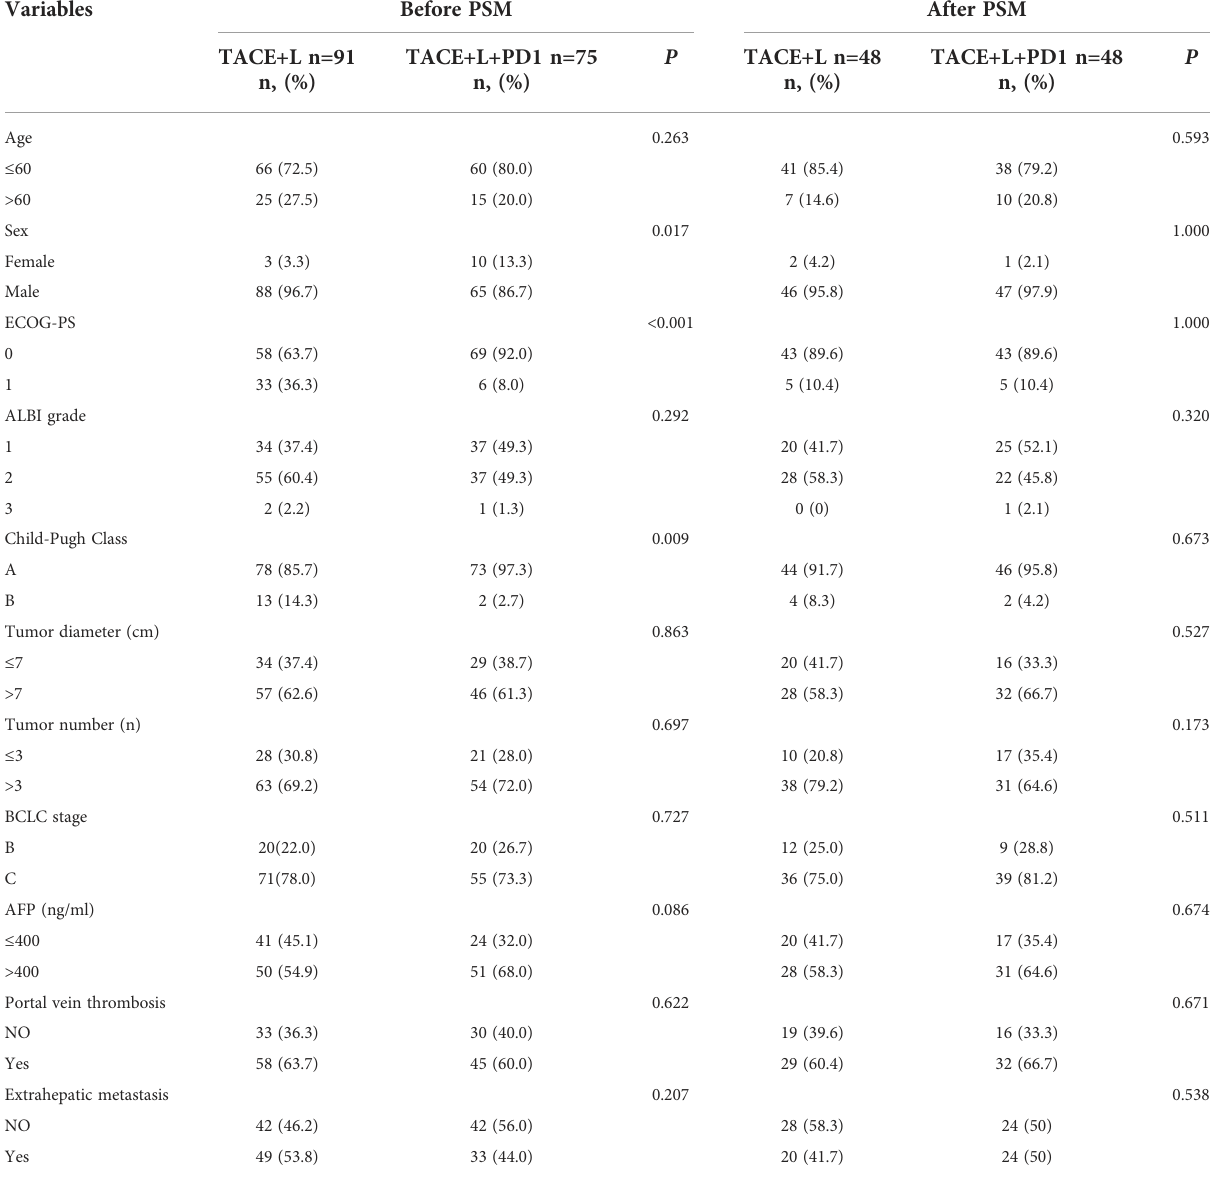
TABLE 1 Baseline characteristics before and after PSM. Variables Before